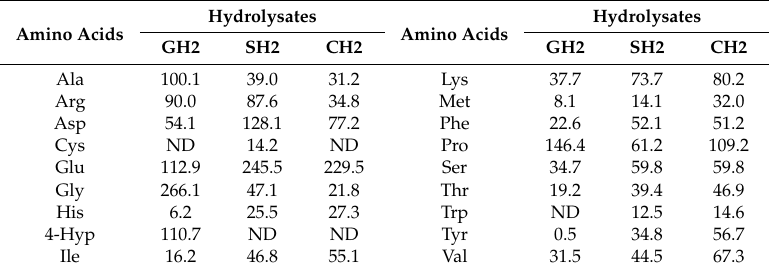
Table 1. Amino acid compositions (g/kg protein) of three hydrolysates.